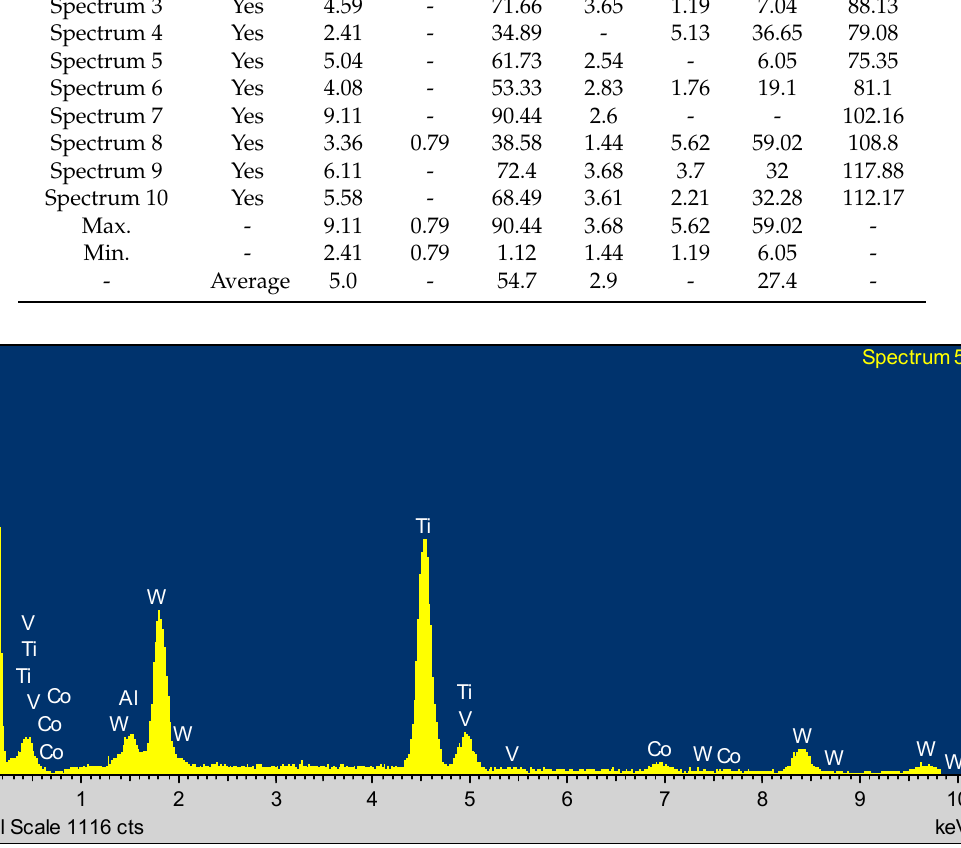
Figure 5. Energy dispersive spectrometry (EDS) spectrum of edges of a WC tool cutting Ti with pure Boelube. Table 3. Elemental analysis of surface of the edge of a WC tool cutting Ti with pure Boelube. WC Tool (with Pure Boelube) (all Results in Weight%) Spectrum In stats. Al Ca Ti V Co W Total Spectrum 2